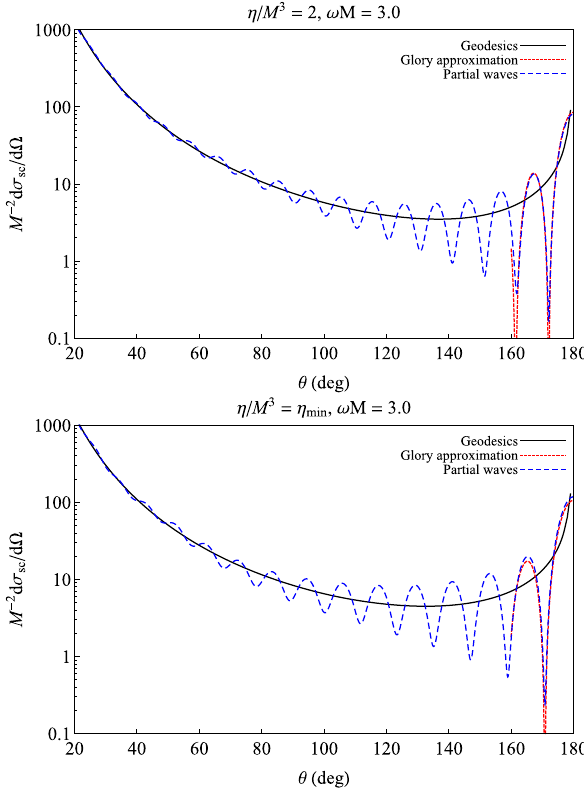
Fig. 4 Differential scattering cross section of parametrized black holes, obtained by geodesics analysis (black solid line), as well as by partial waves approach (blue dashed line). We also exhibit the glory scattering approximation (red dotted line). We consider η/ M 3 = 2 (top panel), as well as η/ M 3 = η min (bottom panel), and ω M = 3 for the wave analysis